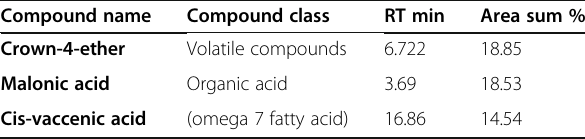
Table 1 Compound(s) biosynthesis by Spirulina platensis on gas chromatography-mass spectrum